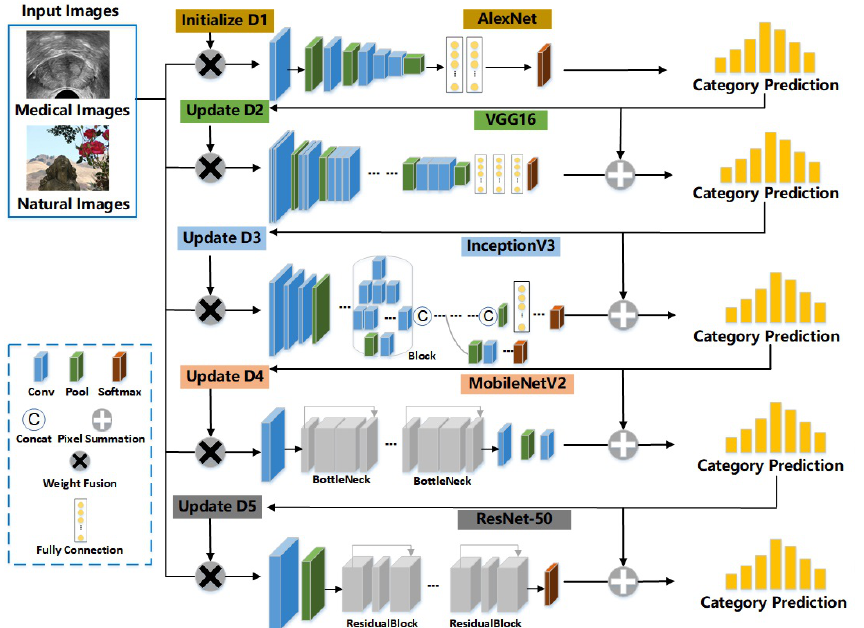
Figure 1. An overview of HCNNs. In this paper, the HCNN consists of five sub-networks, i.e., Alexnet, VGG16, Inception V3, Mobilenet, and Resnet-50. Each image sample has its weight for the specific sub-networks. D 1 , · · · , D 5 represent the image weights for the sub-networks, respectively. Each sub-network combines the results of the previous sub-networks to make